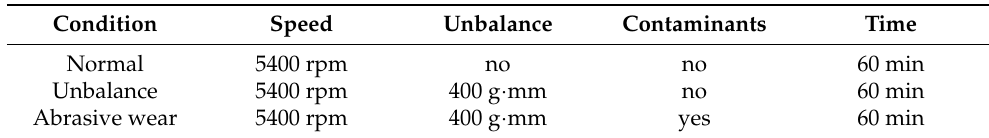
Table 4. The contents of the